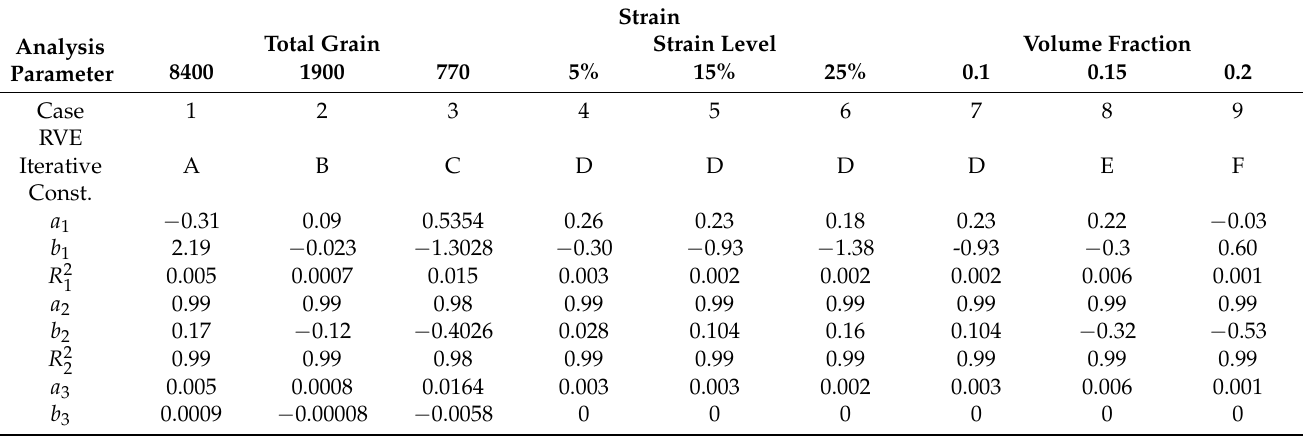
Table A2. Constants a m , b m , and R 2 m (m = 1, 2, 3, 4) for the martensite phase of linear equation with strain condition by the proposed iterative